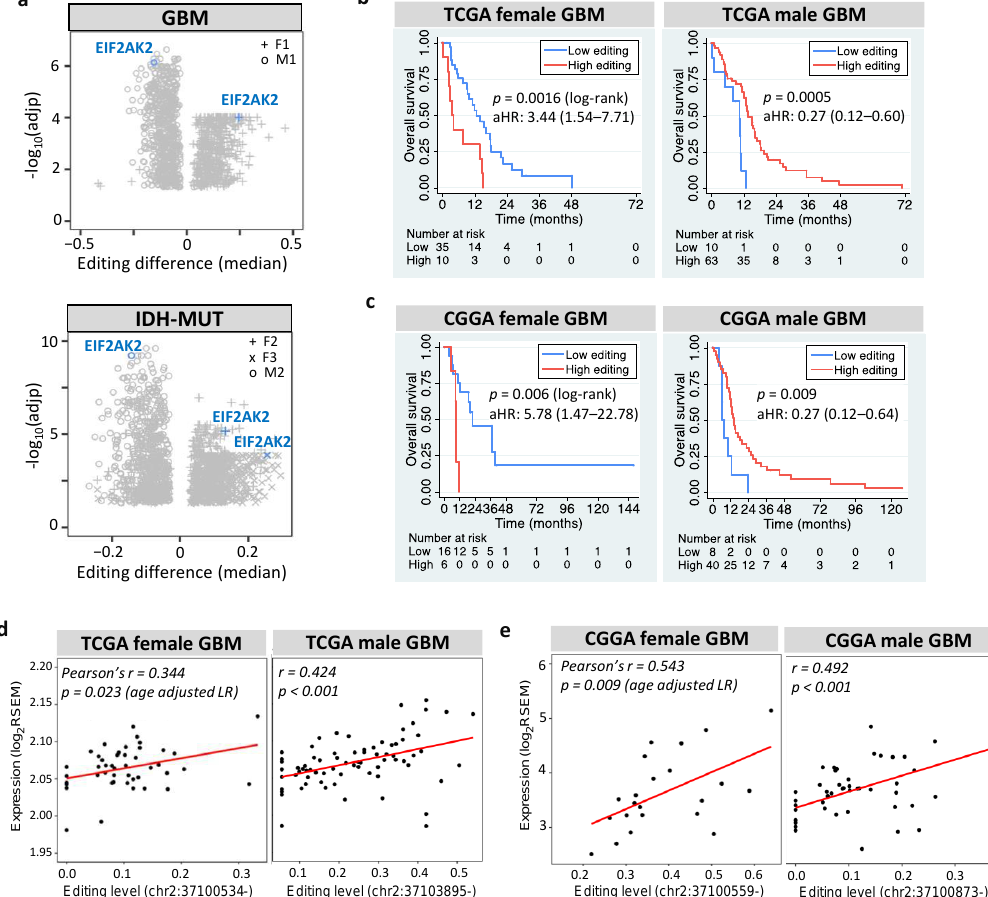
Figure 7. Prognostic value and editing-expression correlation of EIF2AK2 . ( a ) Editing differences of EIF2AK2 between high- and low-risk gliomas. Comparisons are made for GBM (F1: G 2 vs. G 1 and M1: G 1 vs. G 2 ) and IDH-MUT gliomas (F2: GH vs. ODI 1 ; F3: ODI 2 vs. ODI 1 and M2: GHI 1 vs. GHI 2 ). ( b , c ) display Kaplan–Meier curves for editing levels of EIF2AK2 in TCGA and CGGA GBM samples, respectively. High vs. low: top 30% vs. bottom 70% for females and top 70% vs. bottom 30% for males. aHR: age-adjusted hazard ratio. ( d ) and ( e ) represent scatterplots of editing level and mRNA expression of EIF2AK2 in TCGA and CGGA GBM samples,